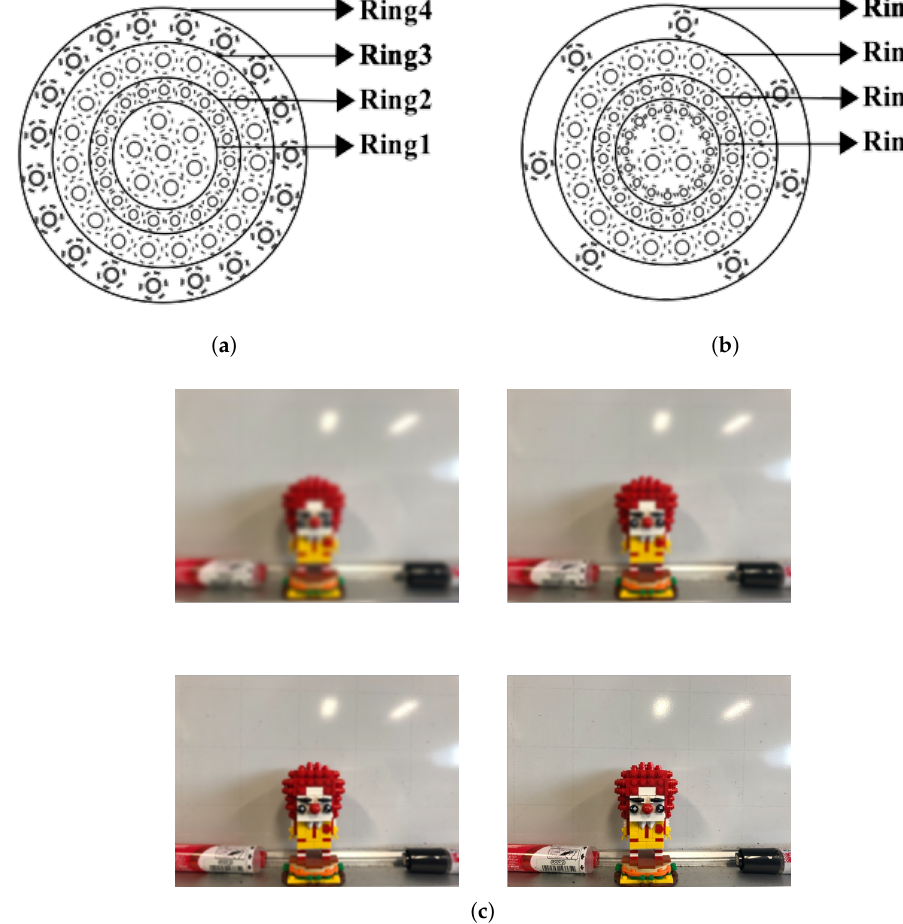
Figure 2. Separating 64-byte BRISK feature descriptors into four rings using grayscale image: ( a ) the sorting ring pattern, ( b ) the inverse sorting ring pattern, and ( c ) scene changes from blurred to